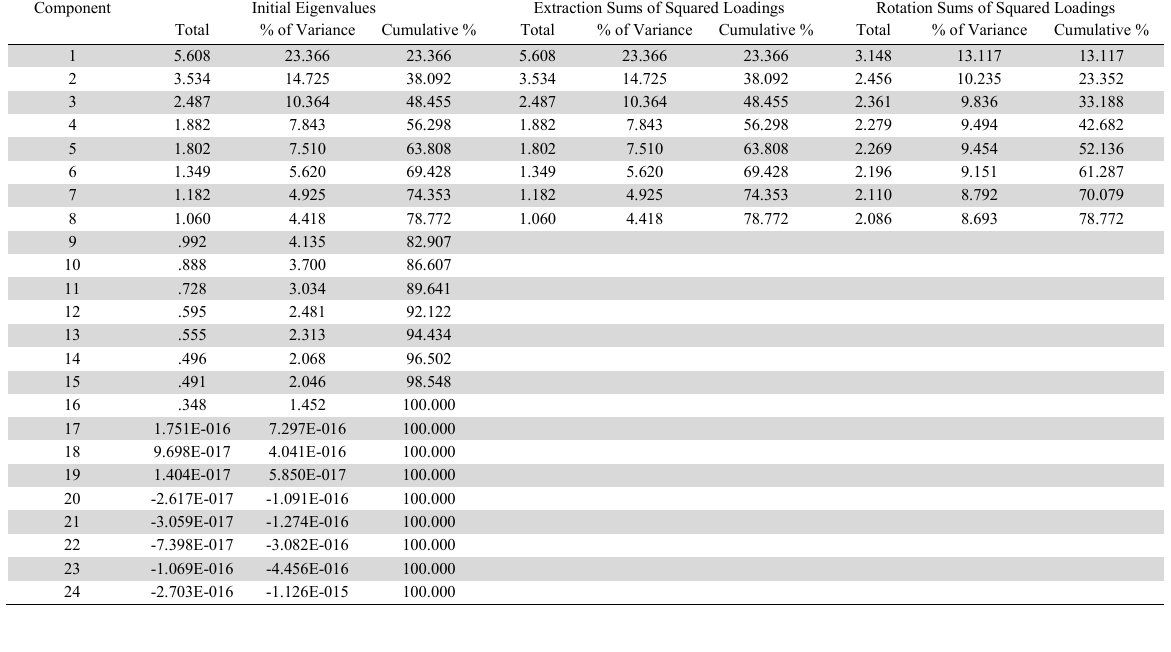
The summary of principle component analysis Component